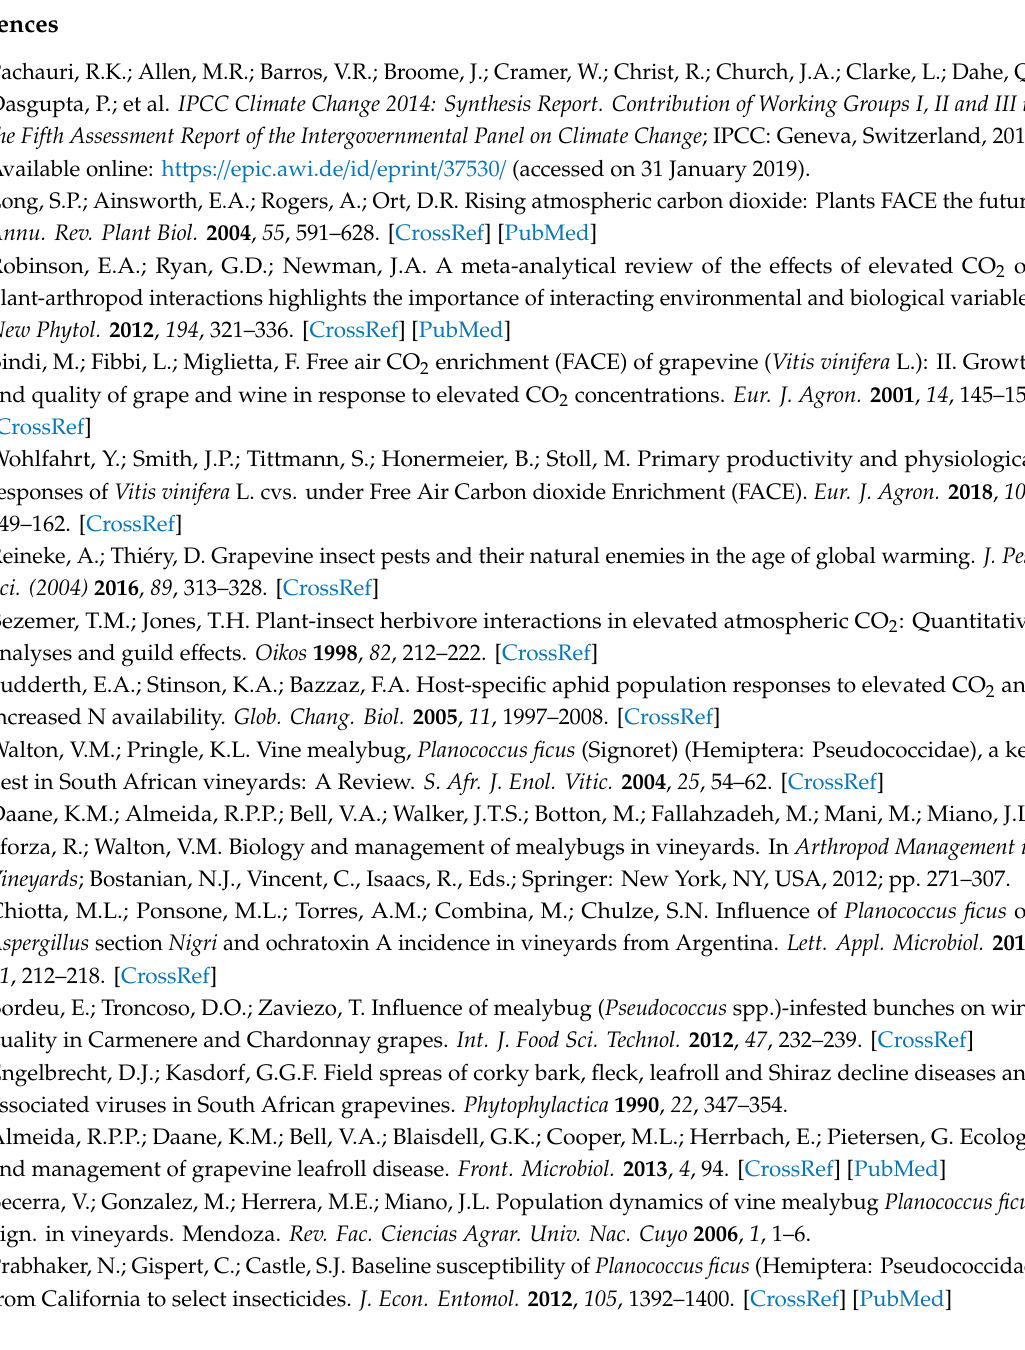
(analysed); Table S5: Greenhouse size and develop; Table S6: Greenhouse Survival; Table S7: Greenhouse fertility fecund; Table S8 FACE results (analysed); Table S9: FACE size and development; Table S10: FACE Survival; Table S11: FACE Fertility Fecundity; Table S12: Greenhouse Leptomastix; Table S13: FACE